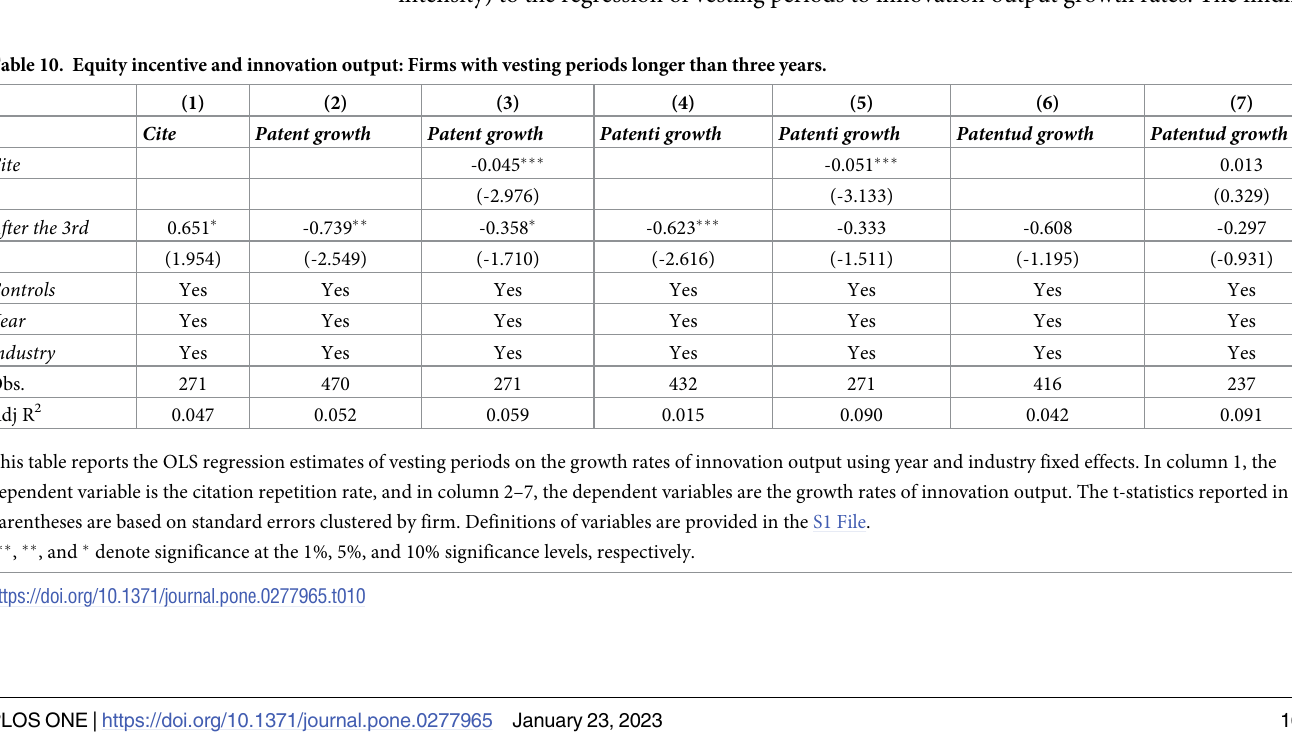
This table reports the OLS regression estimates of vesting periods on the slopes of innovation output using year and industry fixed effects. The dependent variables are the slopes of innovation output. The t-statistics reported in parentheses are based on standard errors clustered by firm. Definitions of variables are provided in the S1 File. ��� , �� , and � denote significance at the 1%, 5%, and 10% significance levels, respectively.